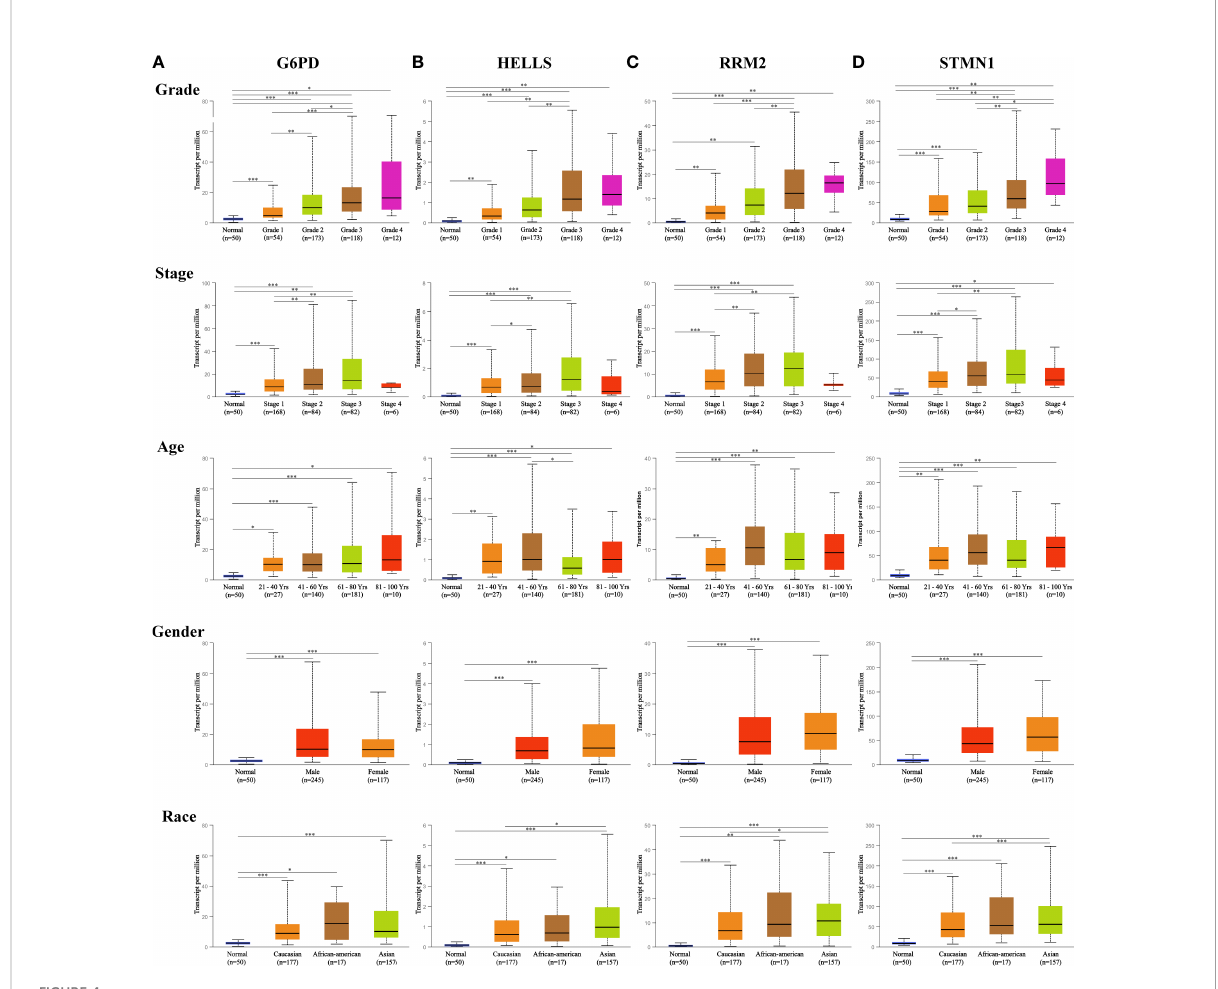
FIGURE 4 Expression of four hub FRGs in HCC strati fi ed by clinical parameters in the UALCAN database. Boxplot showing the mRNA expression of four hub FRGs in HCC patients by stage, grade, age, sex, and race, respectively. (A) G6PD, (B) HELLS, (C) RRM2, (D) STMN1. *P <0.05; **P <0.01; ***P